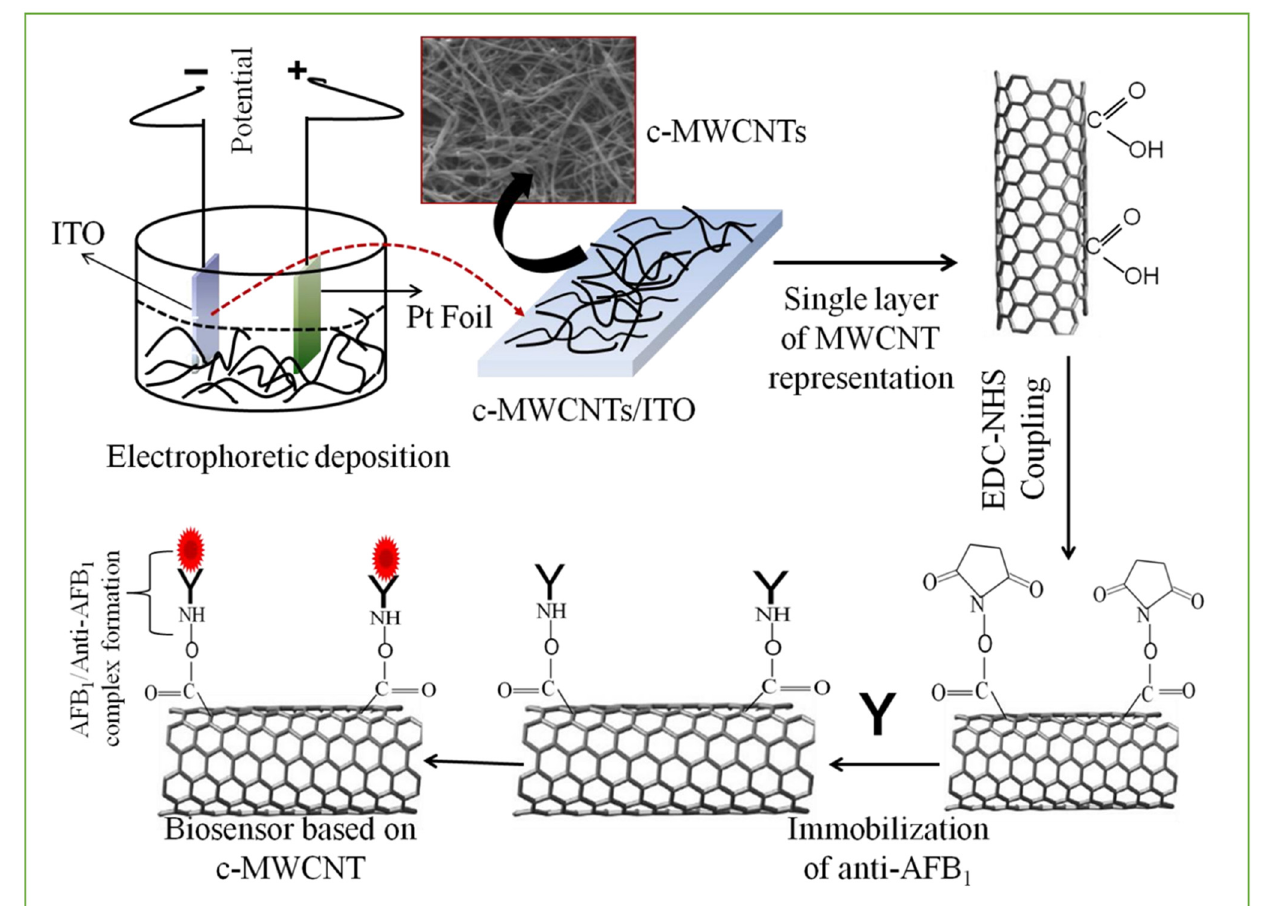
Figure 2. Schematic representation of c-MWCNTs based biosensor for aflatoxin B1 detection. Reprinted with permission from [25]. Copyright 2013 Elsevier.